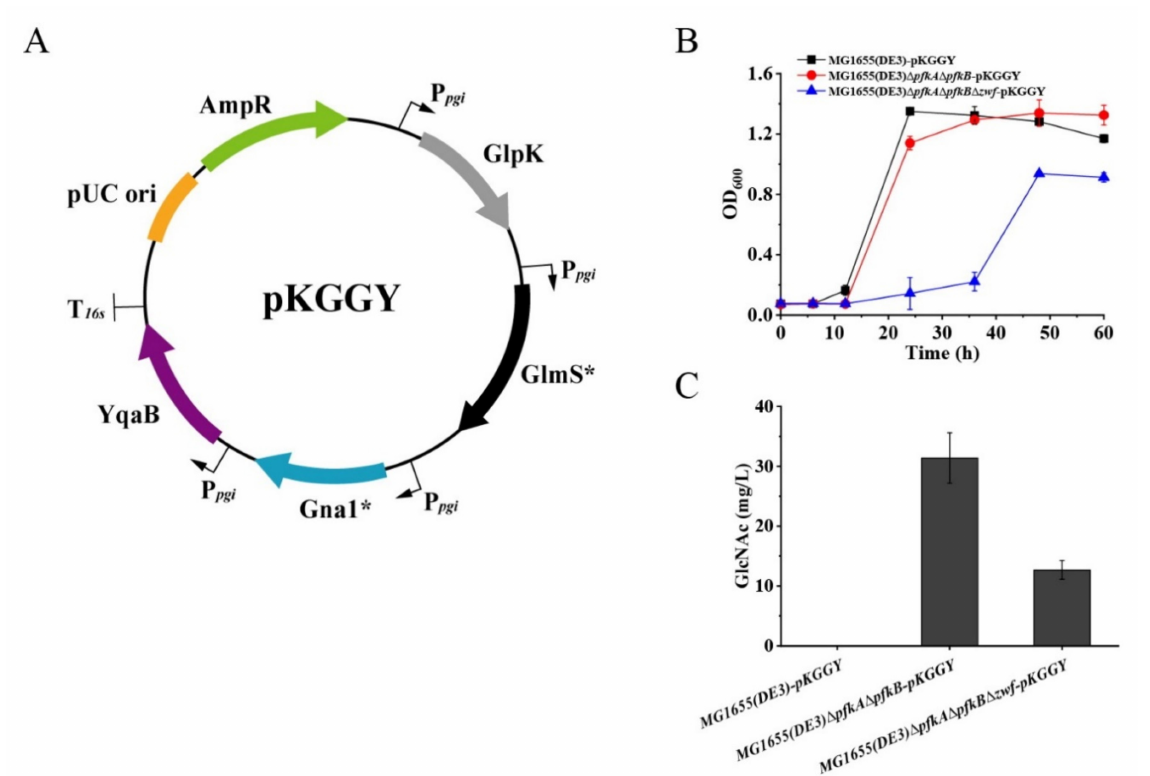
Figure 4. Batch fermentation profiles of MG1655(DE3)-pKGGY, MG1655(DE3) ∆ pfkA ∆ pfkB-